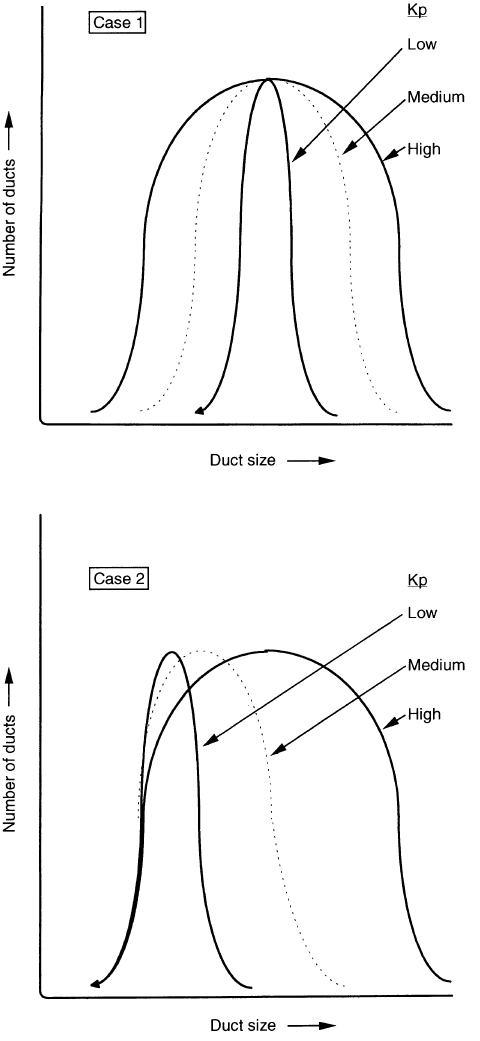
Fig. 7. A plot of possible scenarios of changing duct sizes in order to explain the variations in duct e(cid:129)ciency seen in Fig. 6. The top panel shows how the distribution of duct size may change with magnetic activity levels but where the average size of ducts remains unchanged. The general trend in e(cid:129)ciency is caused by wave-particle ampli- fication. The lower panel shows how the distribution of duct sizes may change with magnetic activity levels in the case where no wave-particle amplification is occurring. The general trend in e(cid:129)ciency is caused by an increase in the average duct size with magnetic activity. See text for more